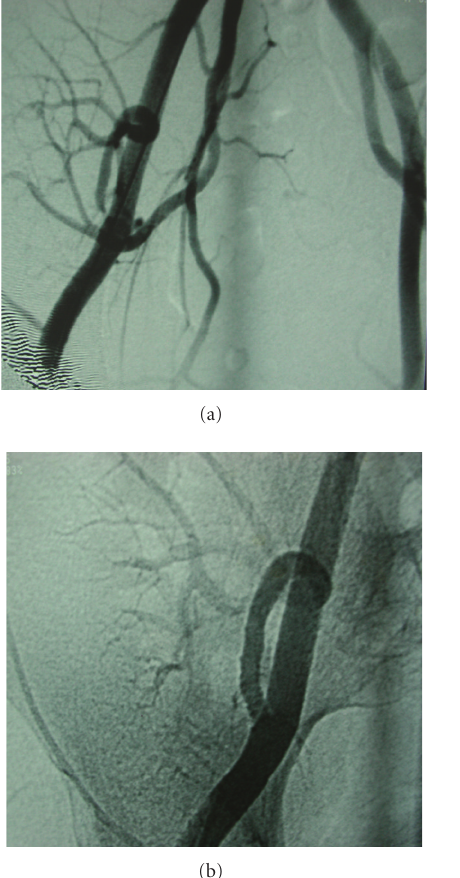
Figure 1: (a) Anastomotic transplant renal artery stenosis. (b) Postpercutaneous transluminal angioplasty and stenting